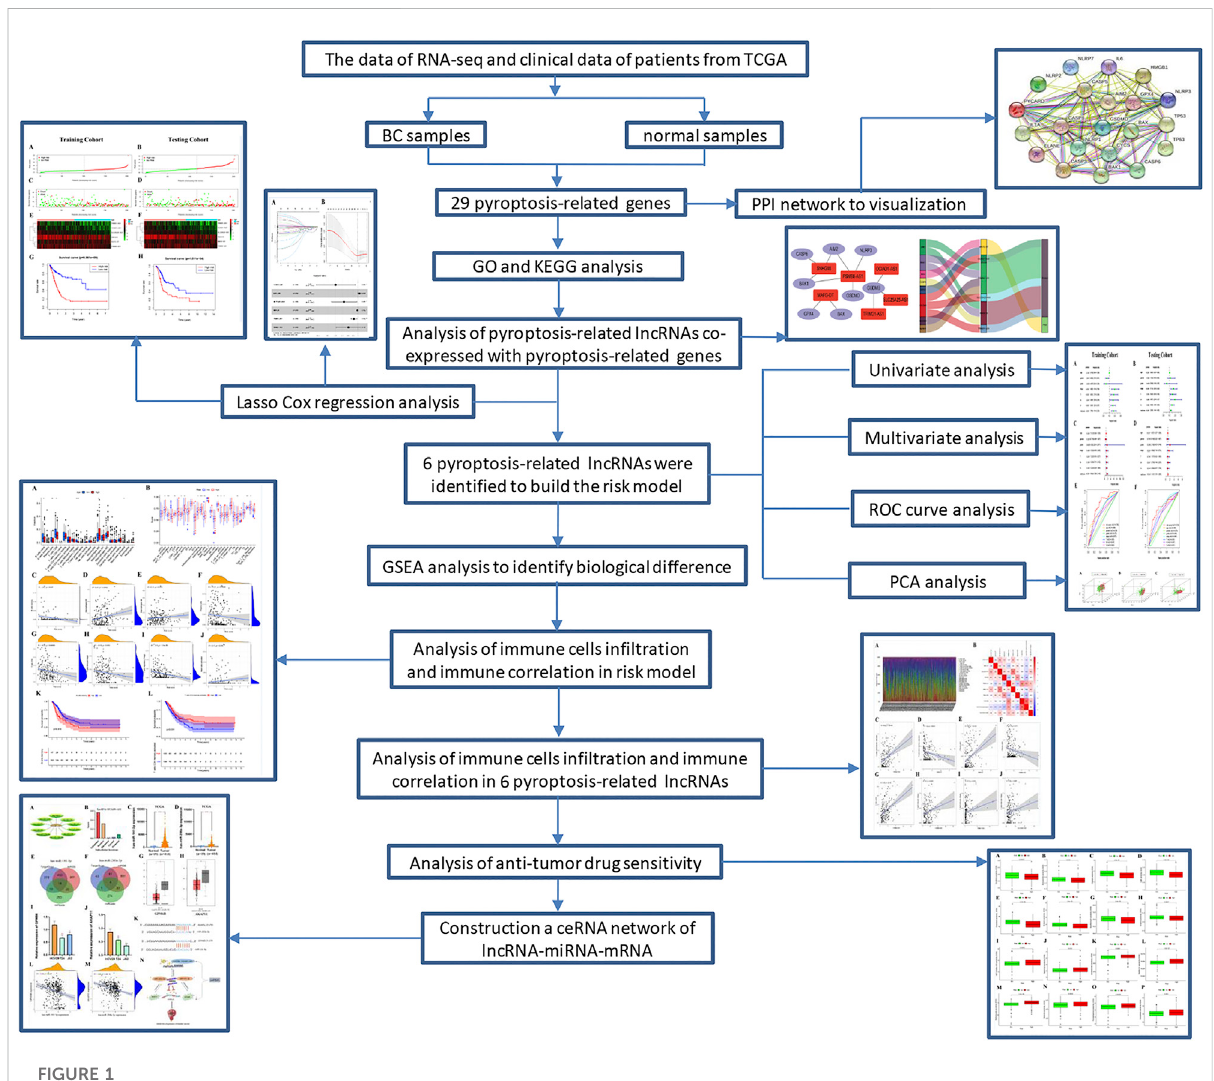
FIGURE 1 Schematic diagram of the